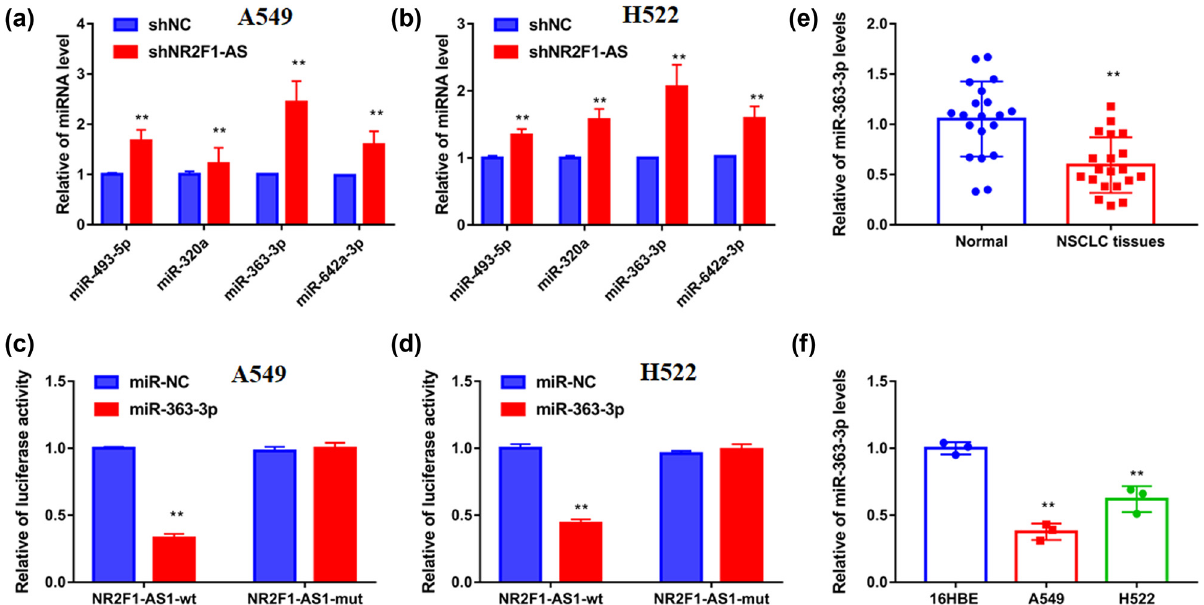
Figure 4: NR2F1 - AS1 served as miR - 363 - 3p sponge in NSCLC cells. ( a and b ) By transfecting with sh - NC or sh - NR2F1 - AS1, the expression of miR - 493 - 5p, miR - 320a, miR - 363 - 3p, and miR - 642a - 3p was assessed in A549 and H522 cells by qRT - PCR. ( c and d ) The connections between miR - 363 - 3p and NR2F1 - AS1 were presented by dual - luciferase reporter assay. ( e ) The level of miR - 363 - 3p in the paired NSCLC samples and adjacent samples was tested by qRT - PCR. ( f ) The expression of miR - 363 - 3p in BEAS - 2B cells and NSCLC cell lines ( A549 and H522 ) was tested by qRT - PCR. ** P < 0.01.